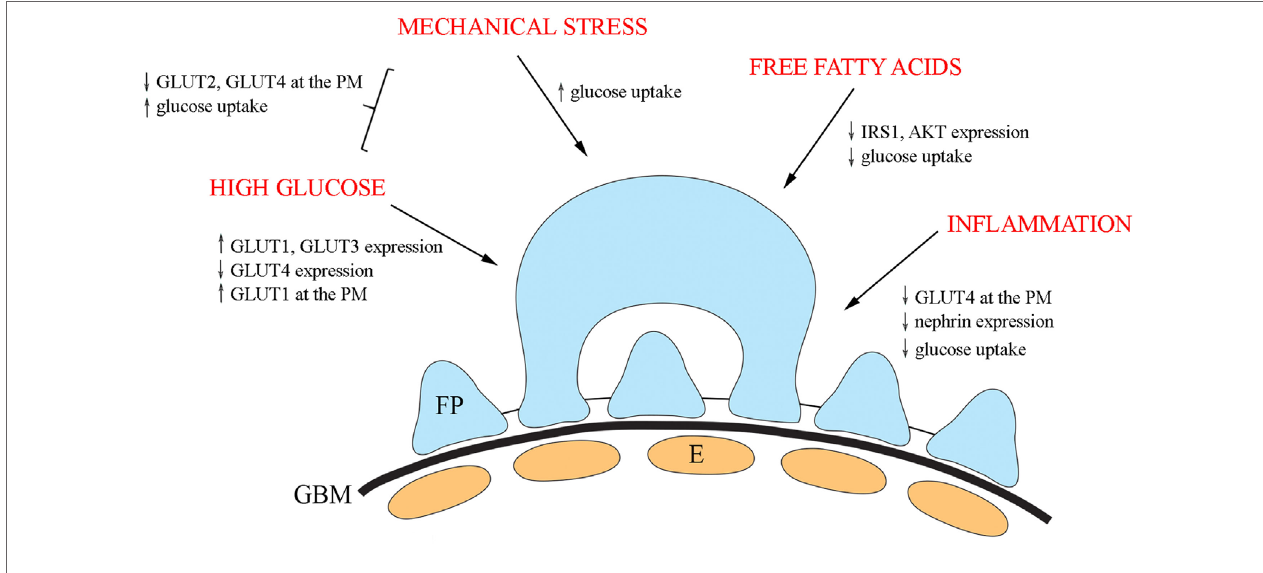
FiGURe 3 | An overview of the diabetes-associated external factors regulating glucose transporters and glucose uptake in podocytes. In cultured podocytes, high glucose leads to upregulation of GLUT1 and GLUT3 and downregulation of GLUT4 and increases the presence of GLUT1 at the plasma membrane. Mechanical stress increases glucose uptake and in combination with high glucose, decreases the expression of both GLUT2 and GLUT4 at the plasma membrane, and increases glucose uptake. Free fatty acids lead to reduced phosphorylation of IRS1 and AKT and diminished glucose uptake. Also, inflammatory mechanisms impair insulin signaling and insulin-induced glucose uptake in cultured podocytes. E, endothelial cell; FP, foot process; GBM, glomerular basement